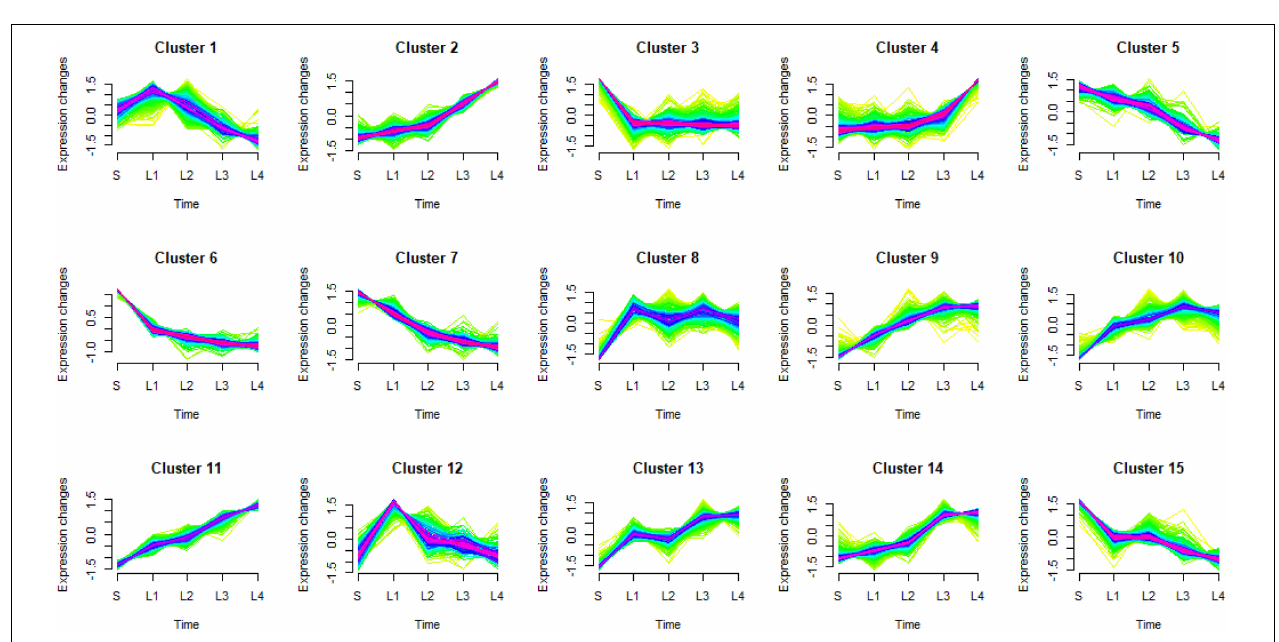
FIGURE 5 | Results of Mfuzz clustering of 4,429 differentially expressed genes (DEGs). S, juice sacs from small-size fruit. L1–L4, juice sacs from large-size fruit, which were classified according to the granulation degree.